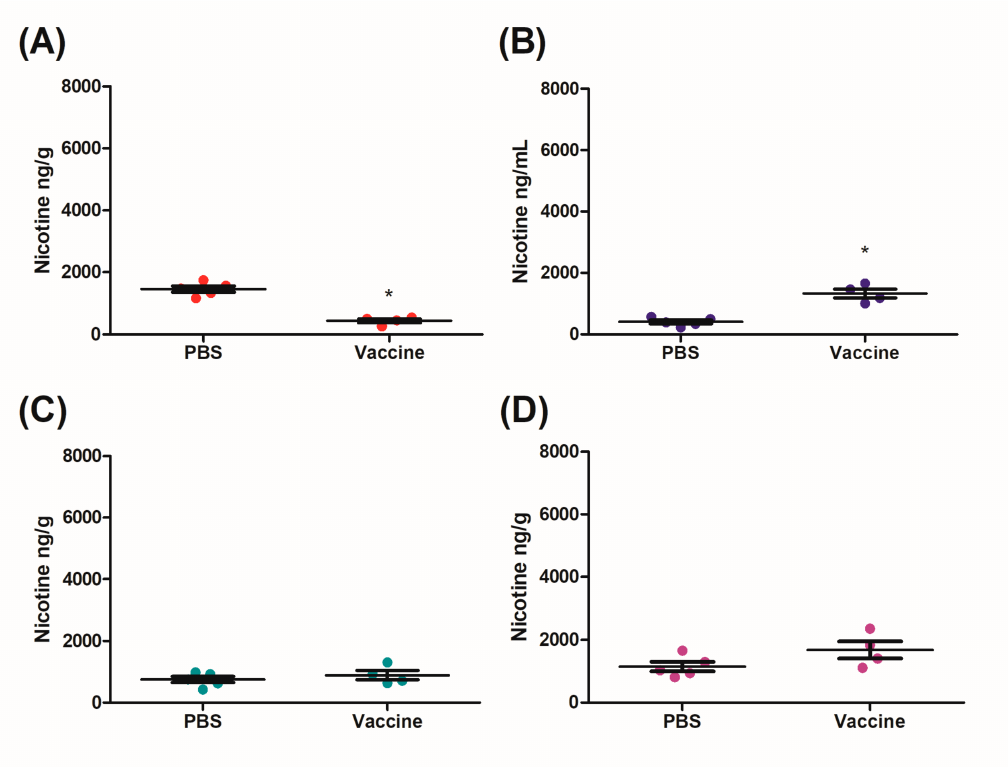
Figure 6. Distribution of nicotine in mice vaccinated IM/IN after a systemic nicotine challenge. IM/IN vaccinated mice were challenged with 0.09 mg/kg of nicotine by an IC injection of 100 µ L. After 5 min the mice were euthanized by a cardiac exsanguination and organs were collected for nico- tine distribution analysis. ( A ) Brain, ( B ) sera, ( C ) lung, ( D ) heart and data are represented as ± SEM and n = 4ˆ–5 for each group. Statistical significances were determined by a Mann–Whitney U-test, * p = 0.0159. ˆ One mouse was removed because of a technical issue during the intracardiac